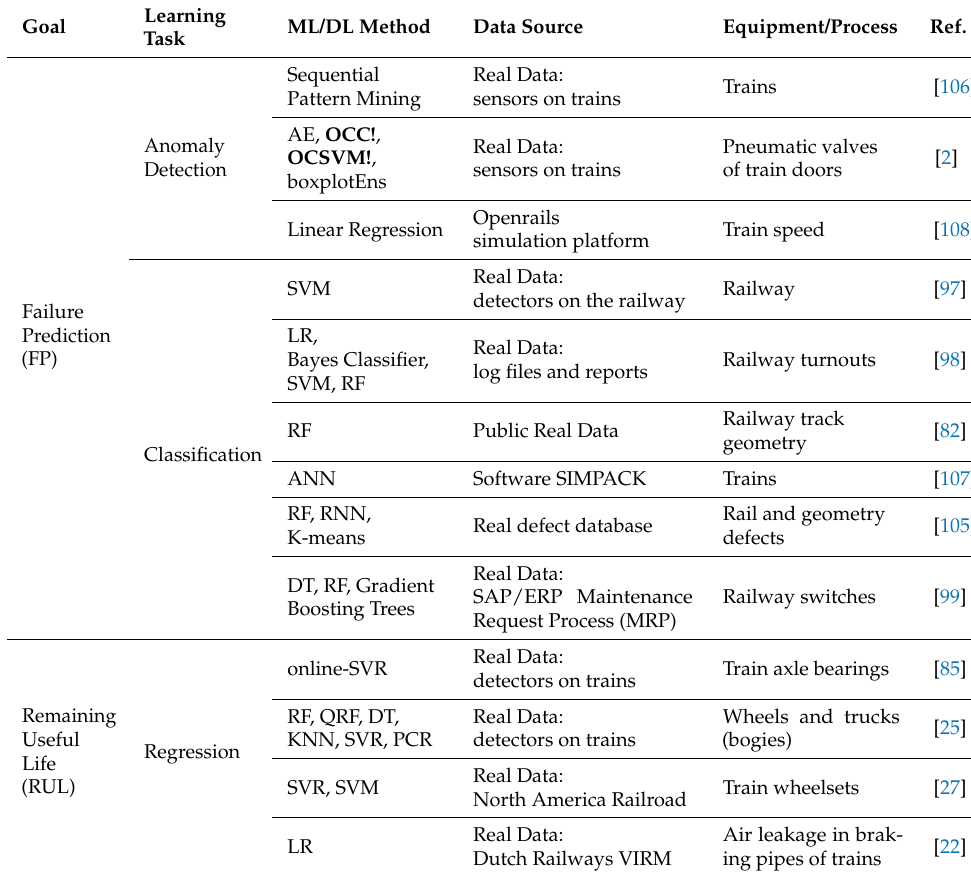
Table 3. Data-driven PdM for the railway